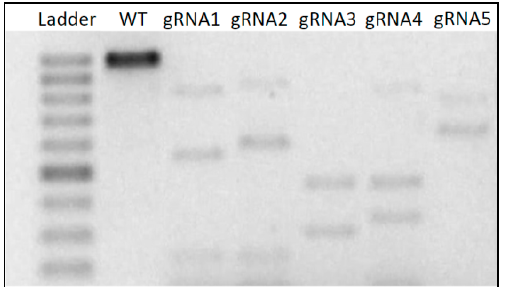
Figure 2. Schematic diagram of the Maize IPK gene locus with the guide RNAs (gRNAs) target sites. The in vitro CRISPR-Cas9 assay showing the original and the cleaved fragments of the IPK gene in maize that were submitted to the RNP complex with the crRNA1, 2, 3, 4, and 5. Note: WT = Wild Type (control).